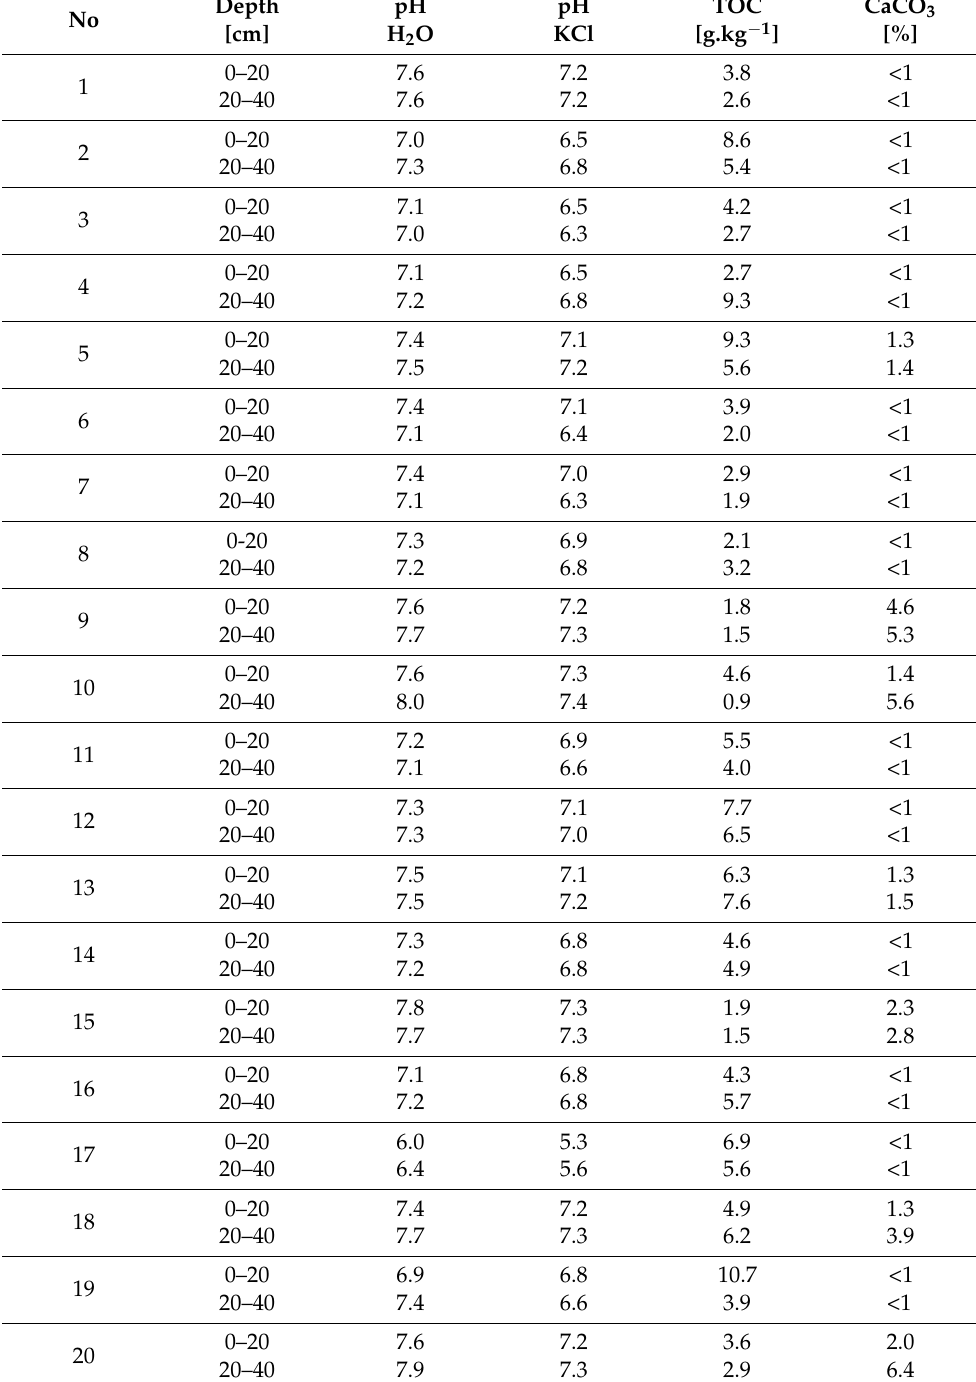
Table 1. Selected physical and chemical properties of